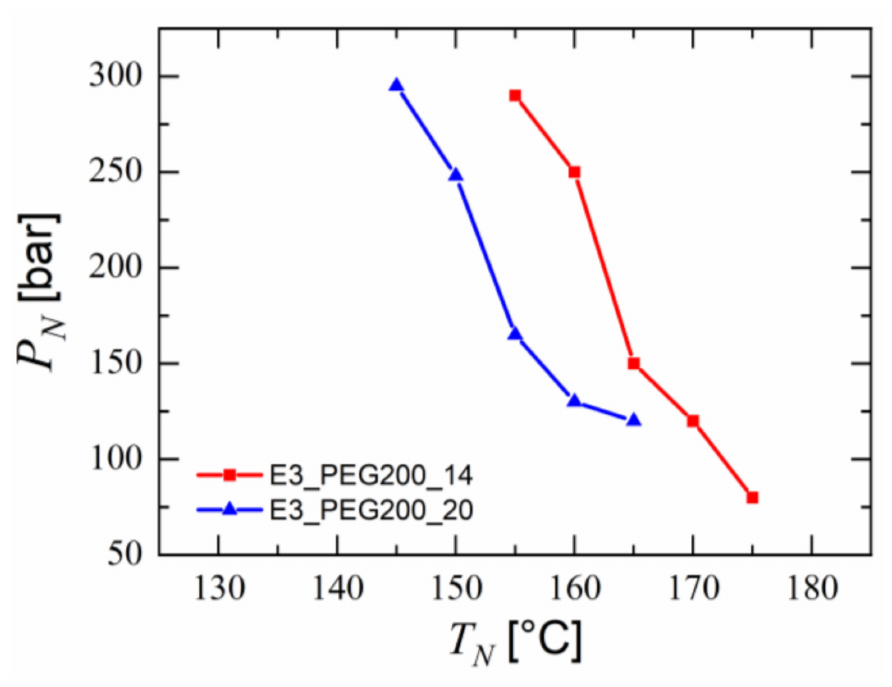
Figure 11. Pressure measured before the nozzle (10 cm) of the foam extruder for PESU/PEG blends at respective nozzle